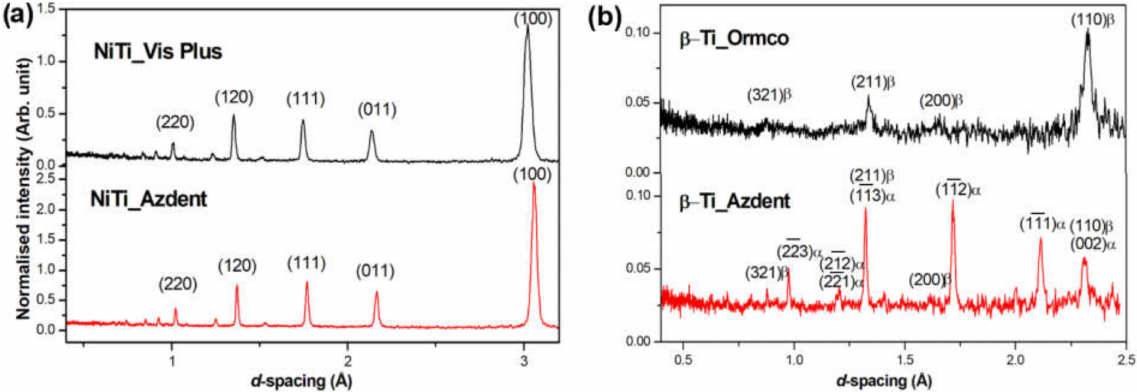
Figure 6. Neutron diffraction patterns of ( a ) NiTi and ( b ) β -Ti